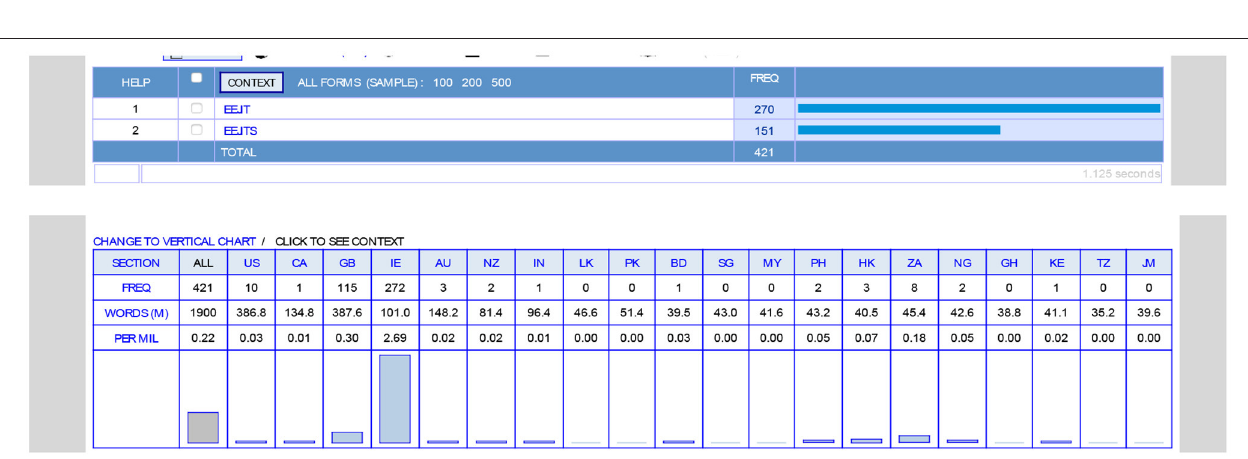
FIGURE 18 | Distribution of eejit/eejits in the GloWbE Corpus (from https://www.english-corpora.org/glowbe/).